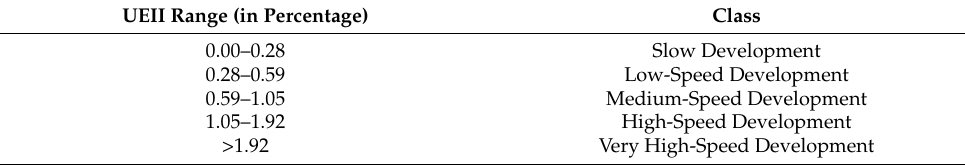
Table 5. UEII range and class.